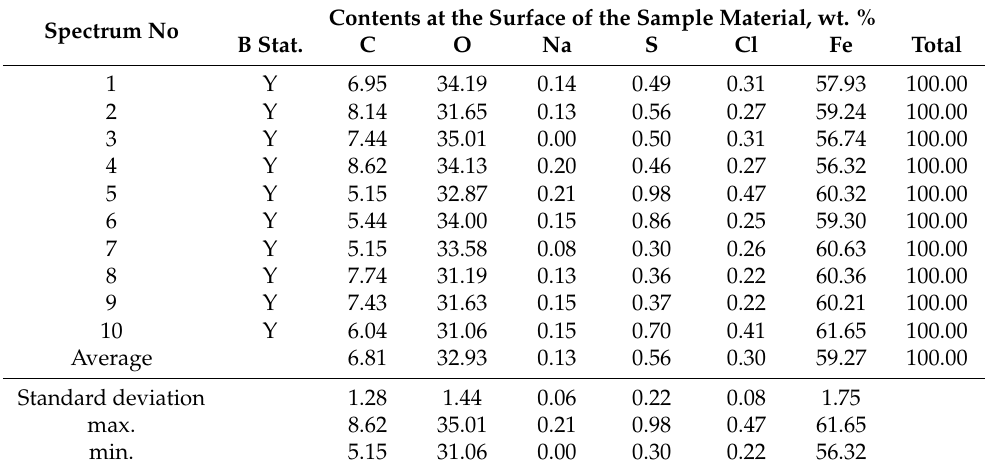
Table 3. Summary data on the study of the elemental composition of the samples welded be- tween steel St3 and steel U7 surface after exposure for 60 days, according to energy-dispersive X-ray microanalysis. Contents at the Surface of the Sample Material, wt. Spectrum No